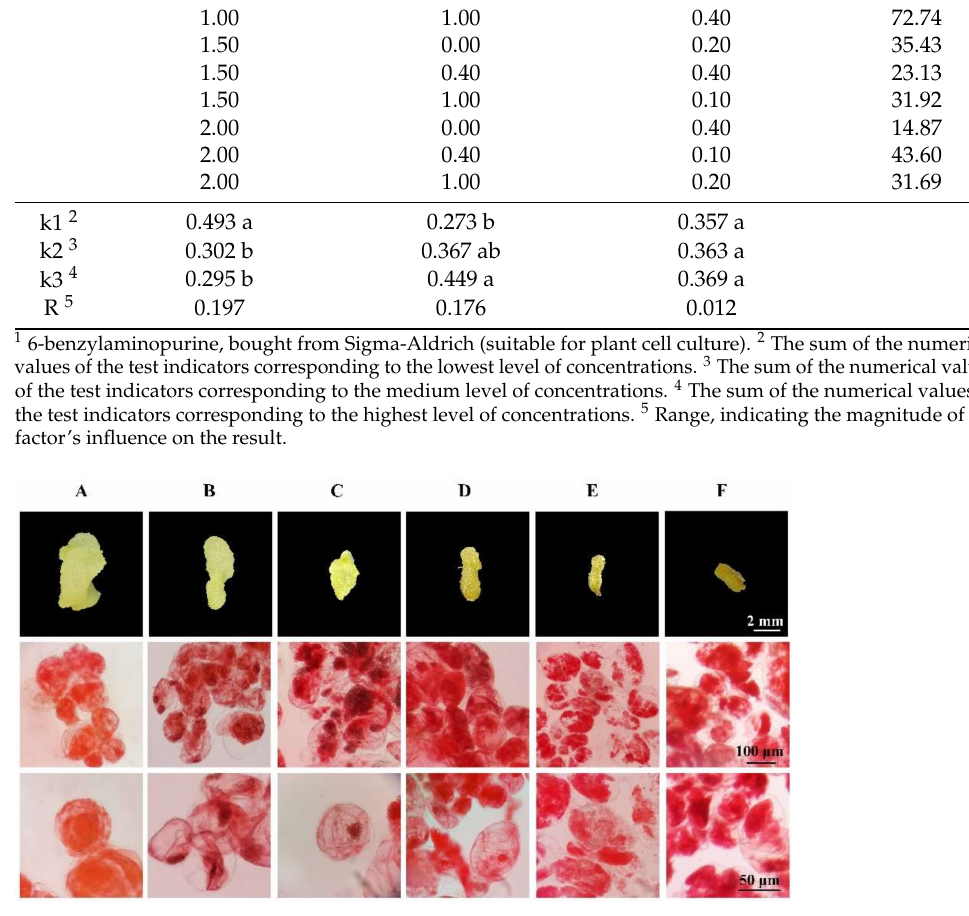
Figure 5. Morphological differences of calluses from A. praecox roots after 15 days of culture. ( A , B ) Creamy-white callus; ( C , D ) Yellowish callus; ( E , F ) Yellow-brown